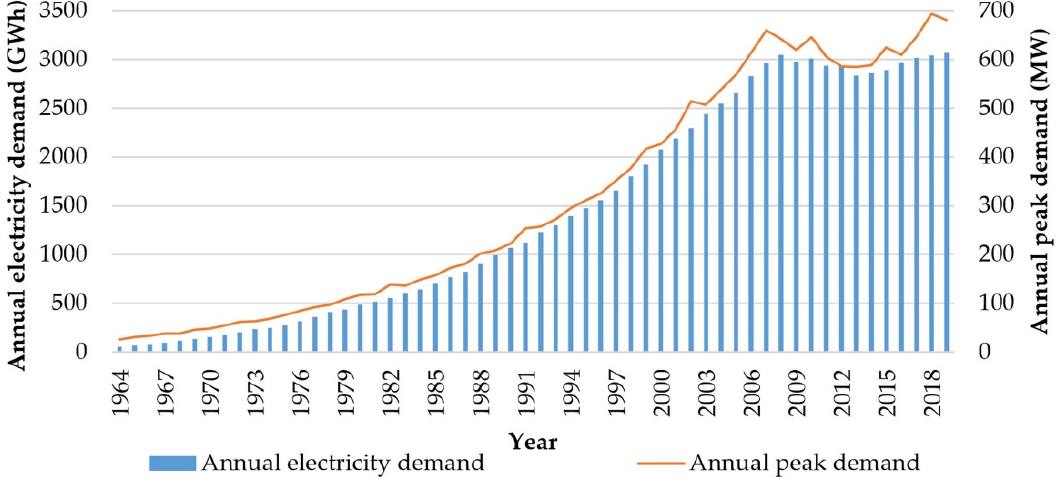
Figure 9. Evolution of the annual peak demand and the annual electricity consumption in Crete since 1964 [50]. 1964 [50].